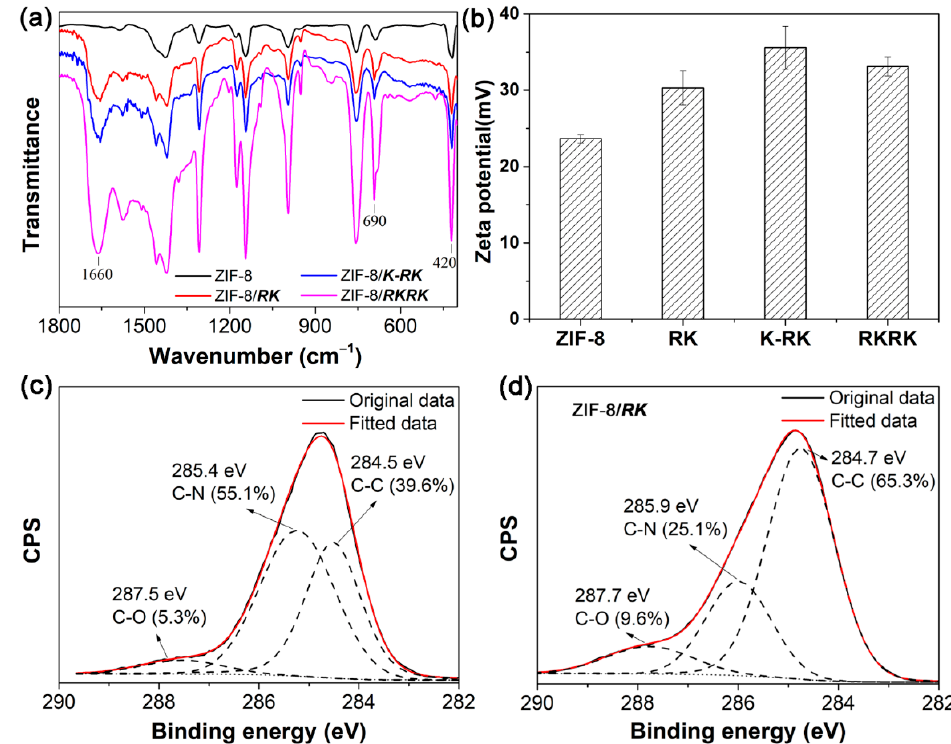
Figure 4. FTIR spectra ( a ) and zeta potential values ( b ) of the ZIF-8 crystals prepared in pure water or in the presence of RKRK , K-RK and RK , respectively. C 1s XPS spectra of the ZIF-8 prepared in pure water ( c ) and in the presence of peptide RK ( d ).